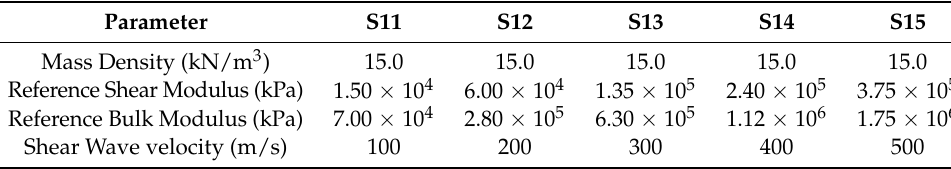
Table 2. Infill soil parameters. Table 5. S2 soil characteristics.